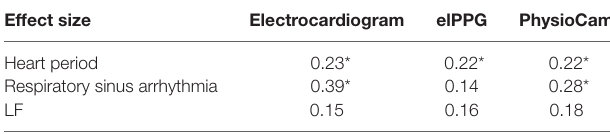
TaBle 5 | Effect size within sensor by heart rate variability